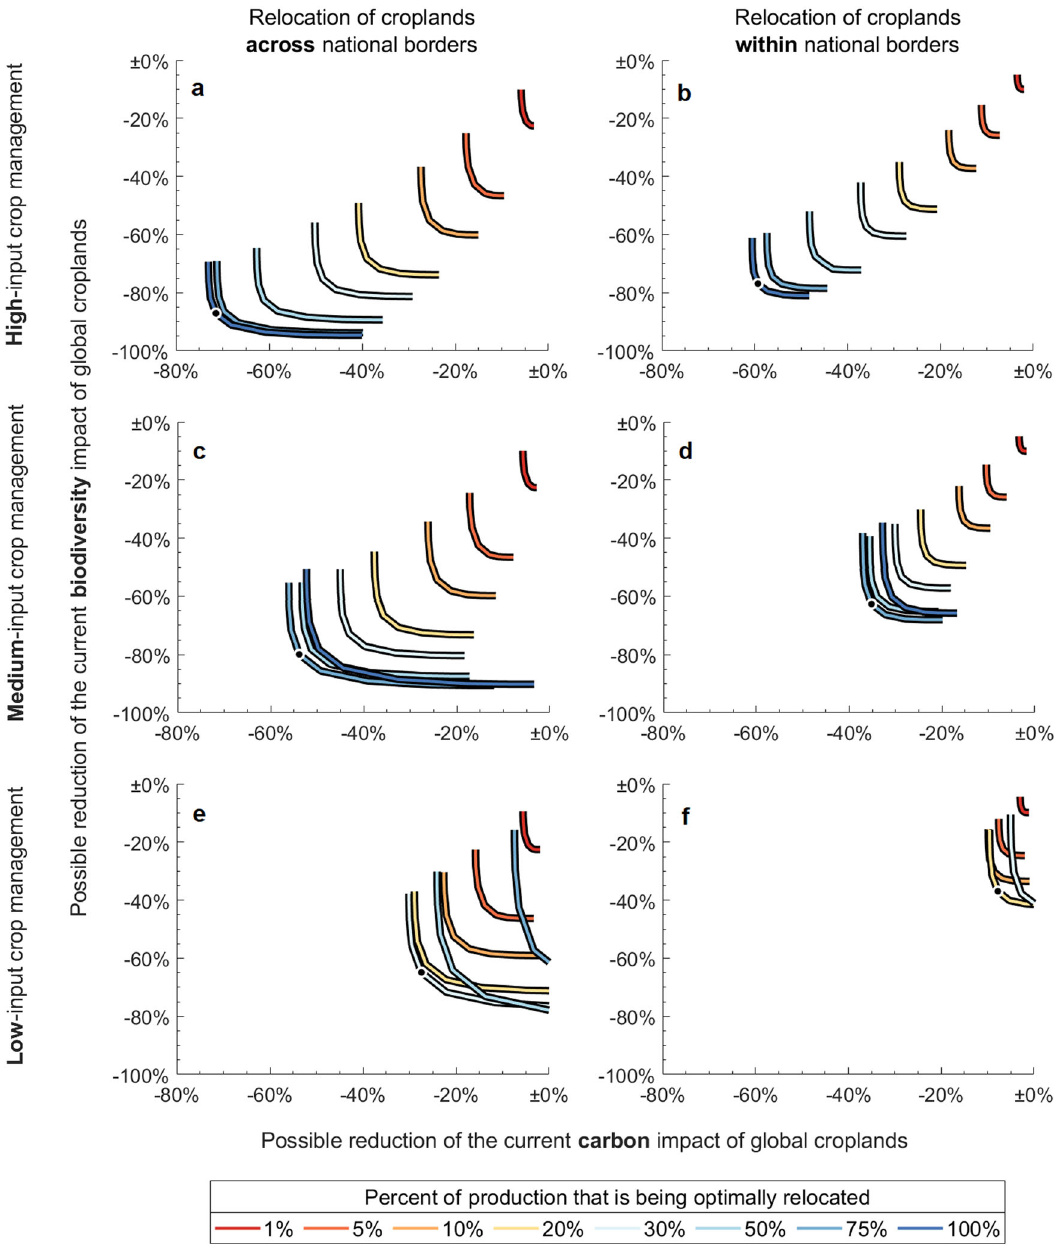
Fig. 3 Reductions of carbon and biodiversity impacts for different relocation levels and management scenarios. Each coloured line represents the set of simultaneously achievable carbon and biodiversity impact reductions, relative to current impacts, which vary according to the weight given to them in the optimisation framework (see the “ Methods ” section). As per the data used, relocated croplands are rainfed; the resulting percentage of irrigated croplands in each scenario (ranging between 21% for the current distribution, and 0% and 0.6% in the scenario of full relocation across and within national borders, respectively) is not displayed. Black markers represent the optimal trade-off between carbon and biodiversity impacts (see the “ Methods ” section); those in a and b correspond to the cropland maps in Fig. 1c, d, respectively, and those in c – f to the maps in Supplementary Fig. 3a – d. In all scenarios, the global production levels of individual crops are identical to current ones; in the scenarios of national relocation, this is additionally the case for national production levels. All estimates are based on current climatic